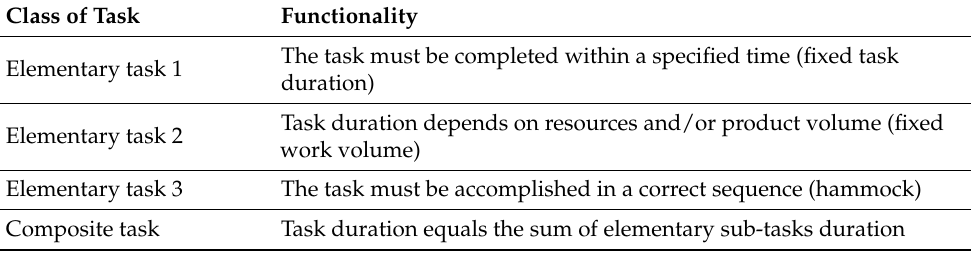
Table 3. Classes of basic tasks.